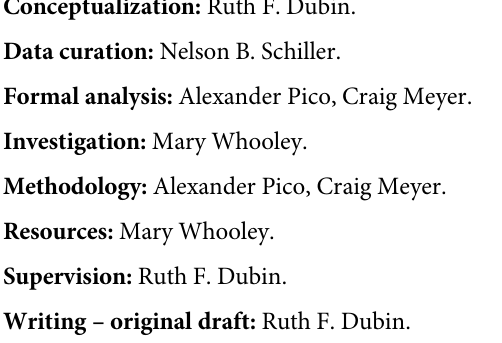
S1 Table. Proteins excluded from current analysis. We excluded 28 proteins from the cur- rent analysis that were labeled in the Heart and Soul proteomic dataset as being assayed with non-human aptamers. S2 Table. Proteins associated with heart failure selected by random survival forest regres- sion among ckd participants of heart and soul. S3 Table. Protein—Heart failure associations with interactions by CKD